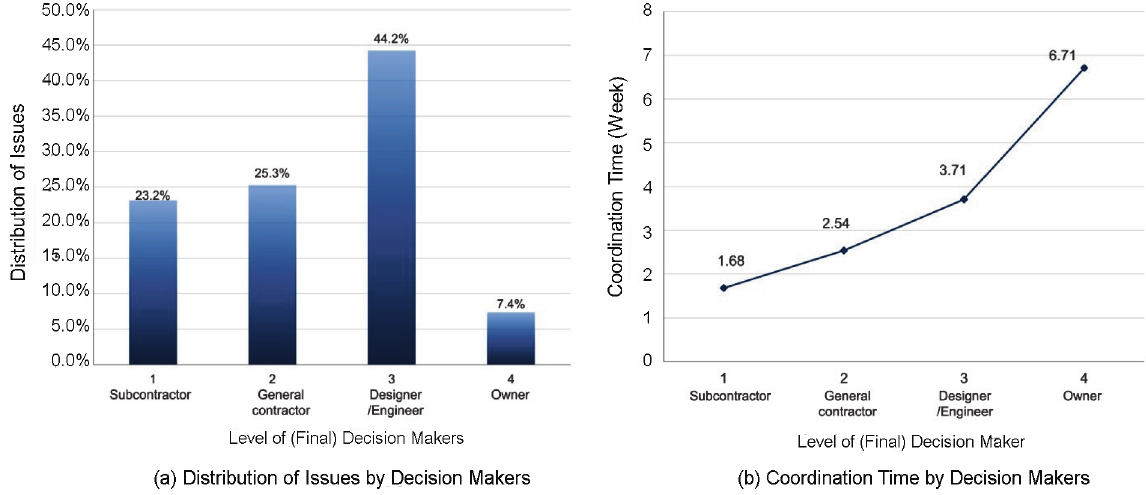
Figure 8. Distribution and coordination time of issues by the level of final decision